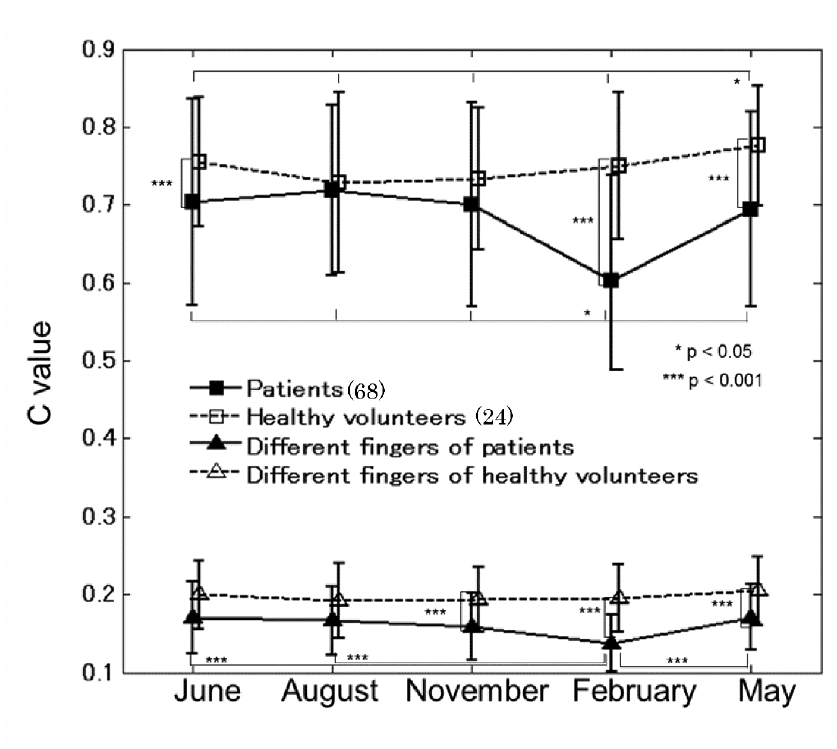
Fig 2. Same-finger and different-fingers authentication results for patients and healthy volunteers. Images obtained on the same day were used for both same-finger ( & / ⬜ ) and different-fingers ( ▲ / 4 ) authentication. Mean values plus/minus one standard deviation are plotted. *** p <